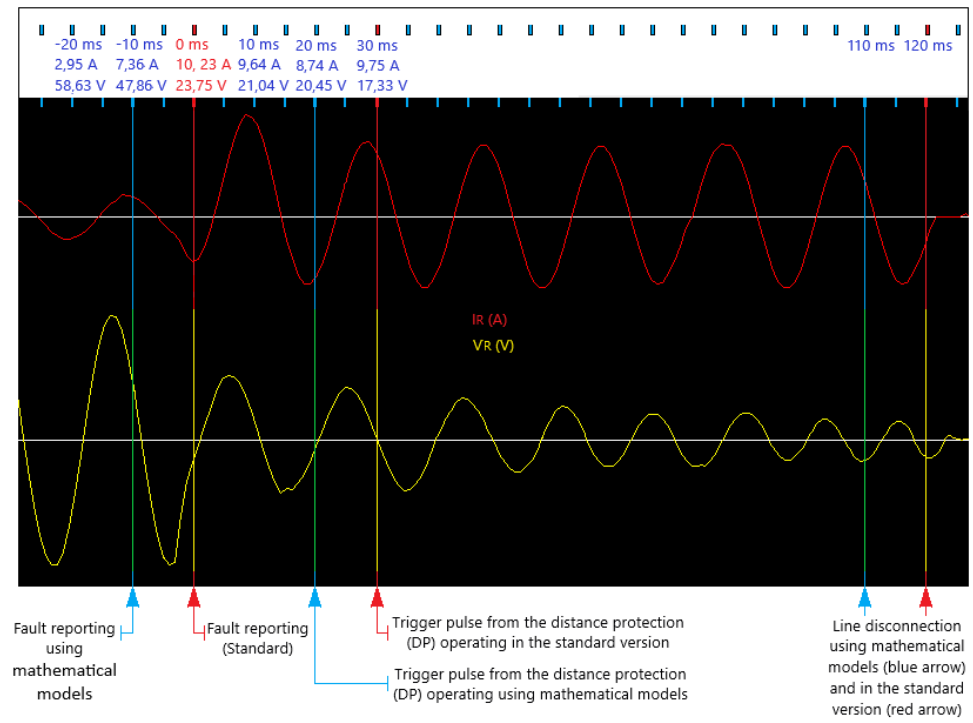
Figure 27. Line disconnection using the proposed structure vs. the standard version.